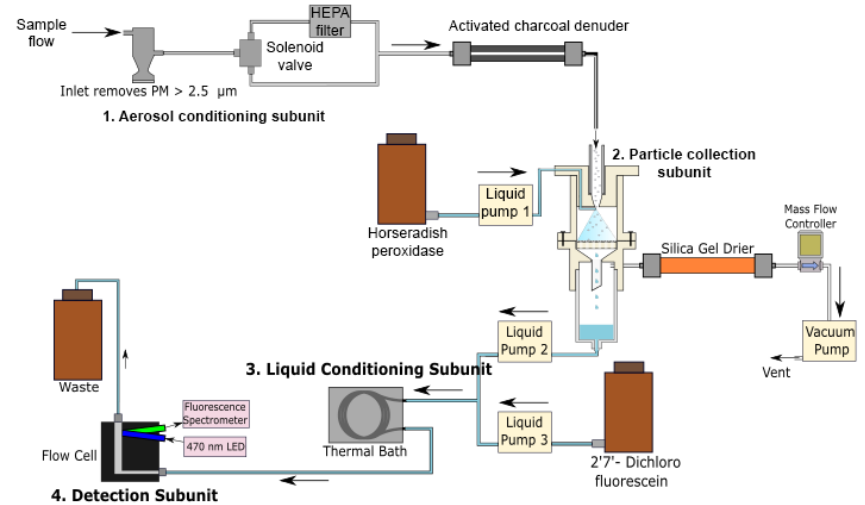
Figure 1. Schematic diagram of the new portable Online Particle-bound ROS Instrument (OPROSI), comprising four labelled subunits: (1) the aerosol-conditioning subunit enables removal of particles > 2.5µm, automated blank measurement and removal of gases such as volatile organic compounds and ozone; (2) the particle collection subunit allows collection of particles into liquid phase, allowing soluble ROS to be extracted; (3) the liquid-conditioning subunit provides suitable time and temperature for the reaction between the DCFH–HRP assay and extracted ROS components; and (4) the detection subunit records fluorescence intensity of the assay upon reaction with the